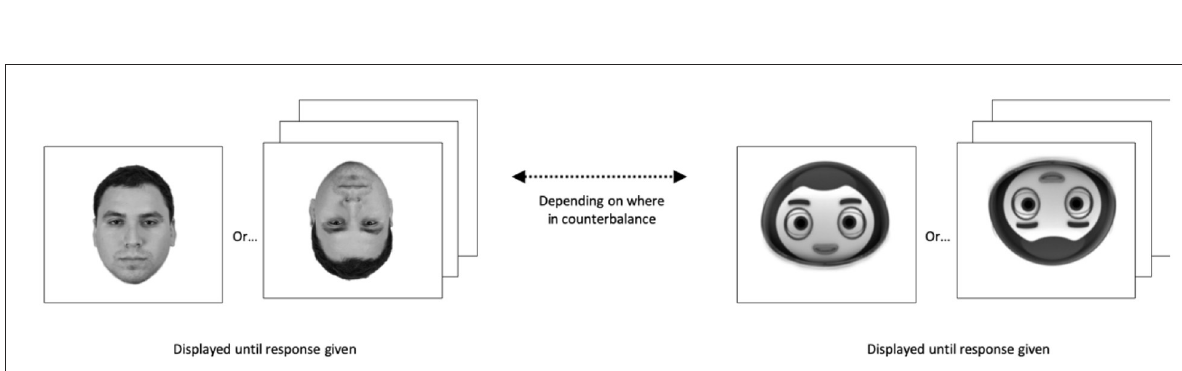
FIGURE3 Recognition phase. Participants were instructed they would see another series of human (or robot depending on counterbalance) faces, some of which they had already seen and had some of which they had not. They were also told some of the faces they had not and had not